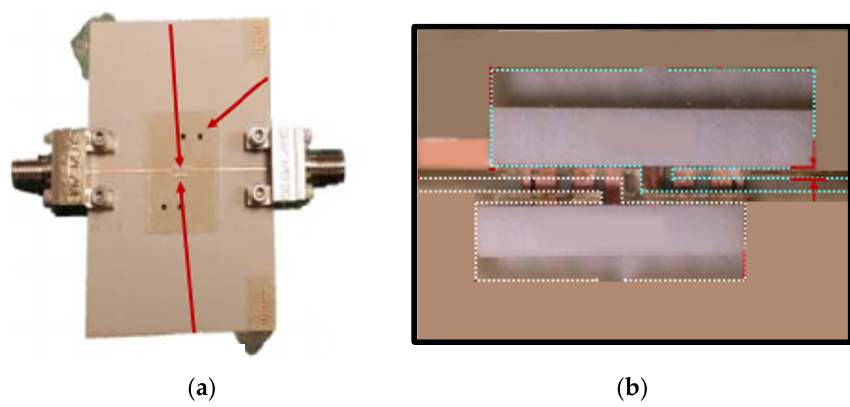
Figure 12. ( a ) Prototype of BPF; ( b ) mircrofluiding channel details.